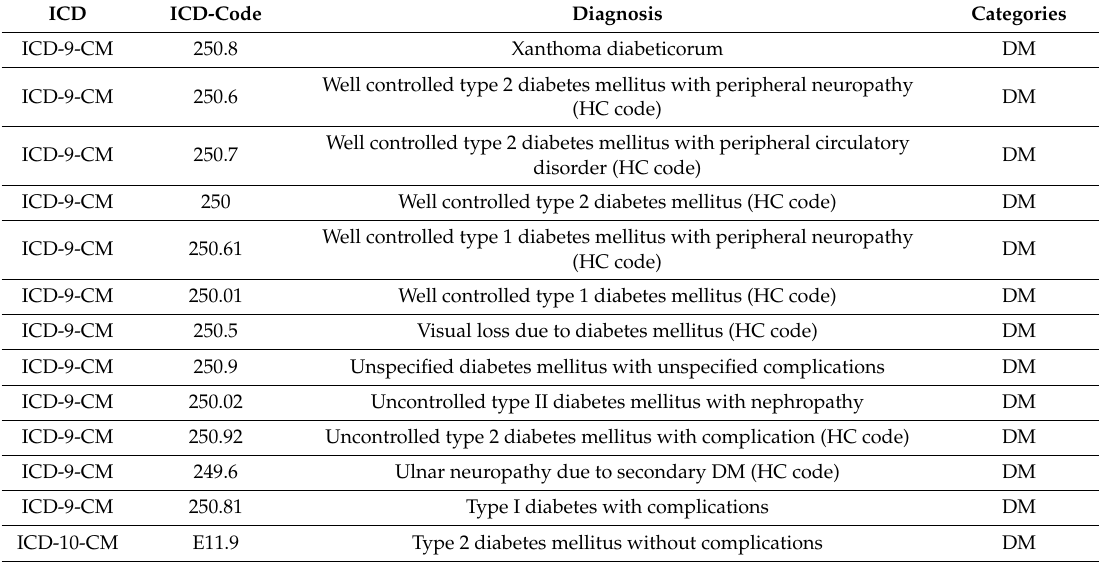
Table A1. List of diagnoses by ICD codes in yellow fever recipients, University of Colorado Hospital, Denver,